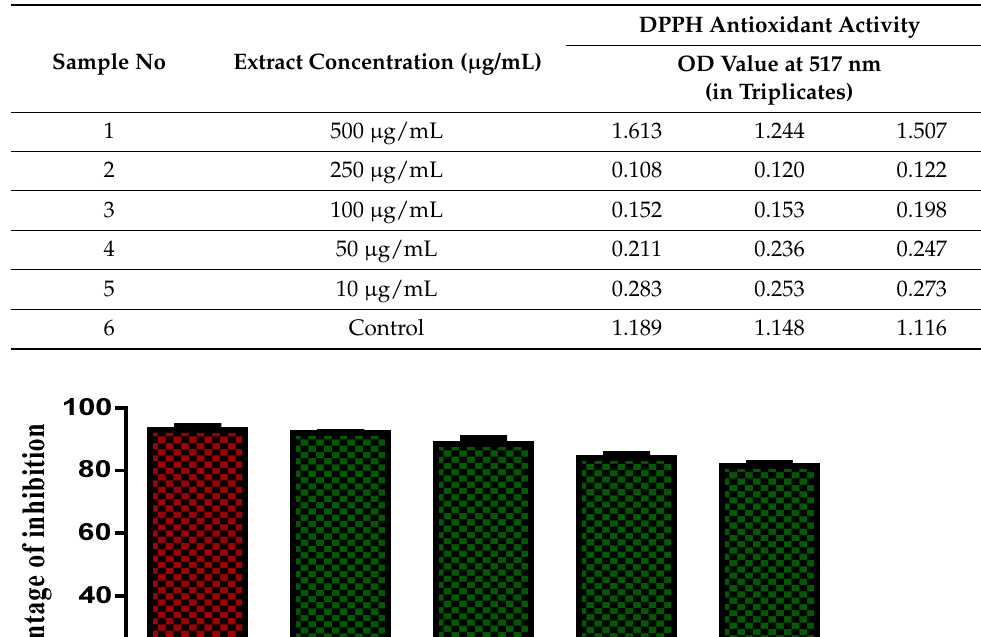
Table 7. The Percentage inhibition and IC 50 value of Ascorbic acid. Table 6. The Percentage inhibition of Argemone Mexicana Leaf Extract.